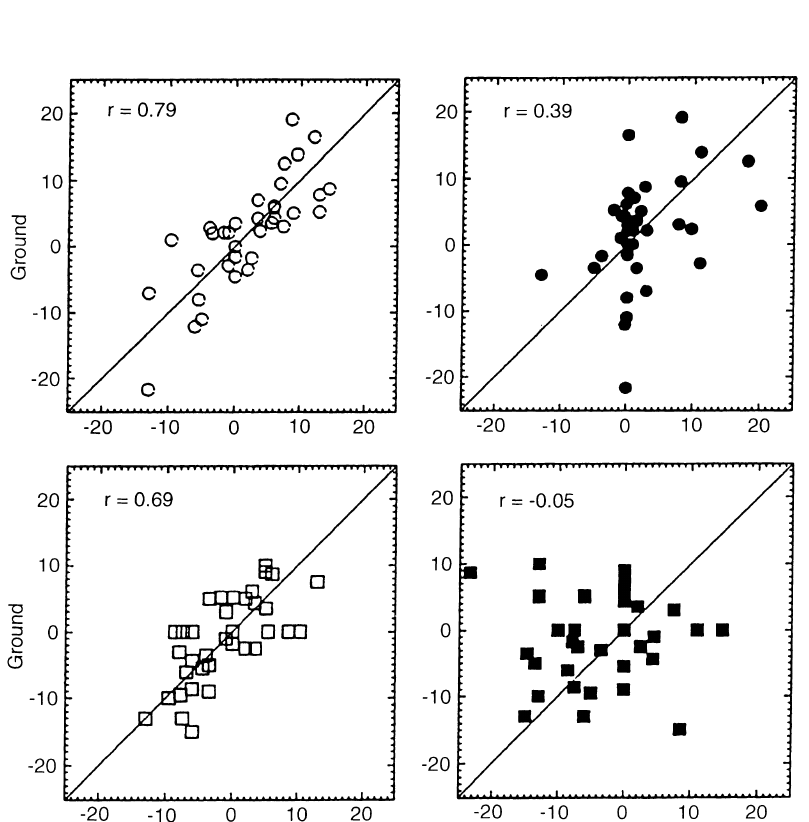
Fig. 5. Comparisons between space-based (ab- scissa) and ground-tidal (ordinate) determina- tions, where results are expressed in the form a cos (cid:120) t (cid:135) b sin (cid:120) t where (cid:120) represents the fre- quency of oscillation, and a and b coe(cid:129)cients are mixed in the presentation. Tidal determinations corresponding to an inclination of 57 (cid:14) for both the northward and eastward wind components from Hawaii, and the eastward wind component from Christmas Island, taken together as a single data set, are depicted. Open circles : diurnal tide from data covering 24-h local time. Open squares : semidiurnal tide from data covering 24-h local time. Solid circles and solid squares represent the corresponding tidal components derived from data covering 12 h local time. The diagonal lines do not represent fits to the data, but correspond to the line of exact agreement. The standard devia- tions of the space-based determinations from these lines, starting at the upper left and moving clockwise, are: 4.48, 10.91, 3.48, and 8.60 m/s. Also provided in the upper left of each panel are